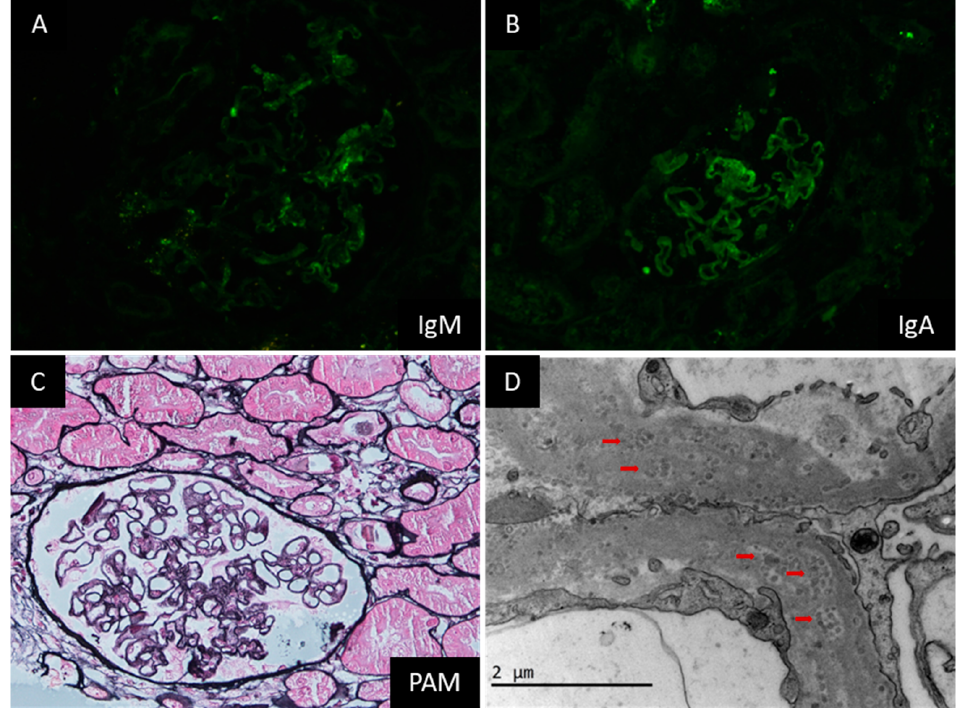
Figure 3. Representative pathological images of renal biopsy specimen form Case 3. Note: IF staining was positive for IgM and IgA in mesangial regions ( A , B ). Light microscopy indicated segmental sclerosis with synechial attachment to Bowman’s capsule in 2/20 glomeruli, mild mesangial matrix expansion, and diffuse thickening of GBM (( C ), PASM + Masson, 400×). Electron microscopy found diffuse podocyte foot process effacement and prominent microspheres (red arrow) in the GBM (( D ), 20,000×).